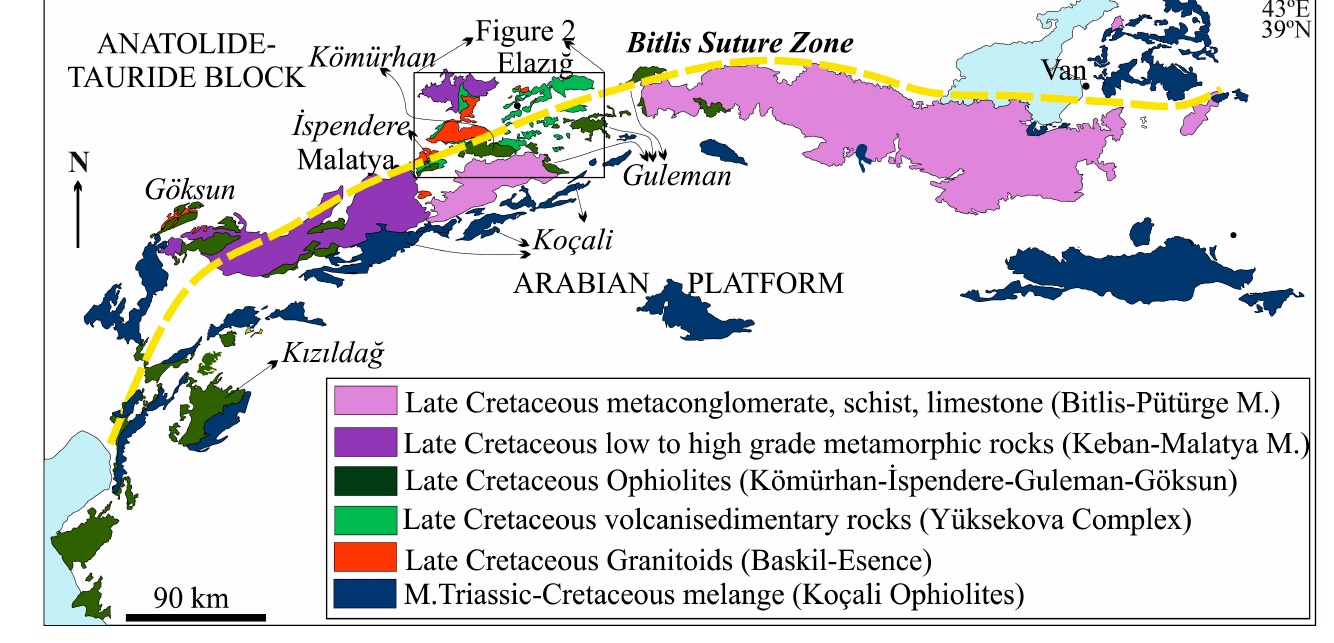
Figure 1. Distribution of the ophiolites, ophiolitic mélanges and various metamorphic areas along the Bitlis suture (modified after [13,14]).